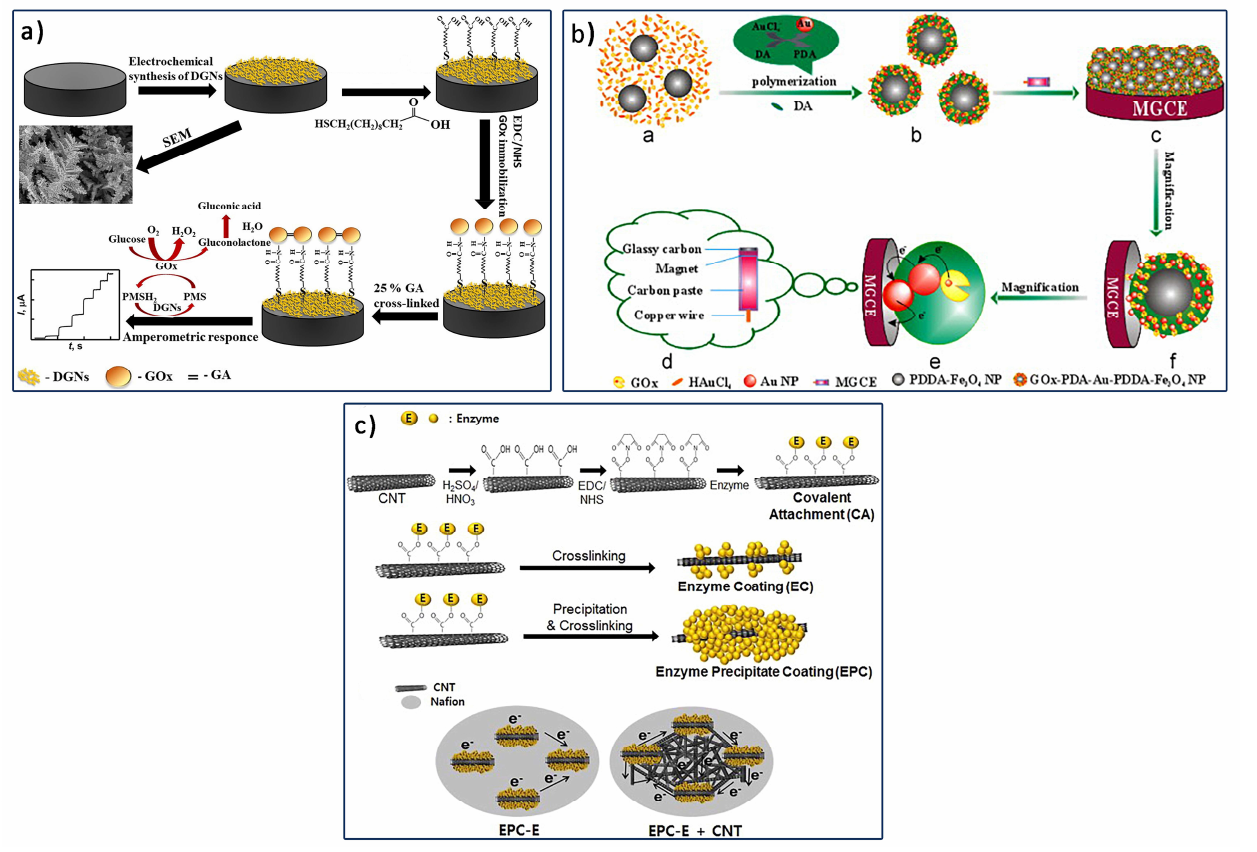
Figure 6. Schematic of fabrication of ( a ) GOx − Au nanostructure/graphite electrode using additional crosslinking reaction after GOx covalently binds with self-assembled monolayer. Reprinted with permission from ref. [105]; Copyright 2022 MDPI. ( b ) Polymerized GOx − AuNP − polydopamine − IONP − modified GCE electrode for glucose biosensor application. Reprinted with permission from ref. [31]; Copyright 2013 Elsevier. ( c ) GOx/CNT/GCE − modified electrode via EPC approach of GOx immobilization. Reprinted with permission from ref. [107]; Copyright 2015 Elsevier.